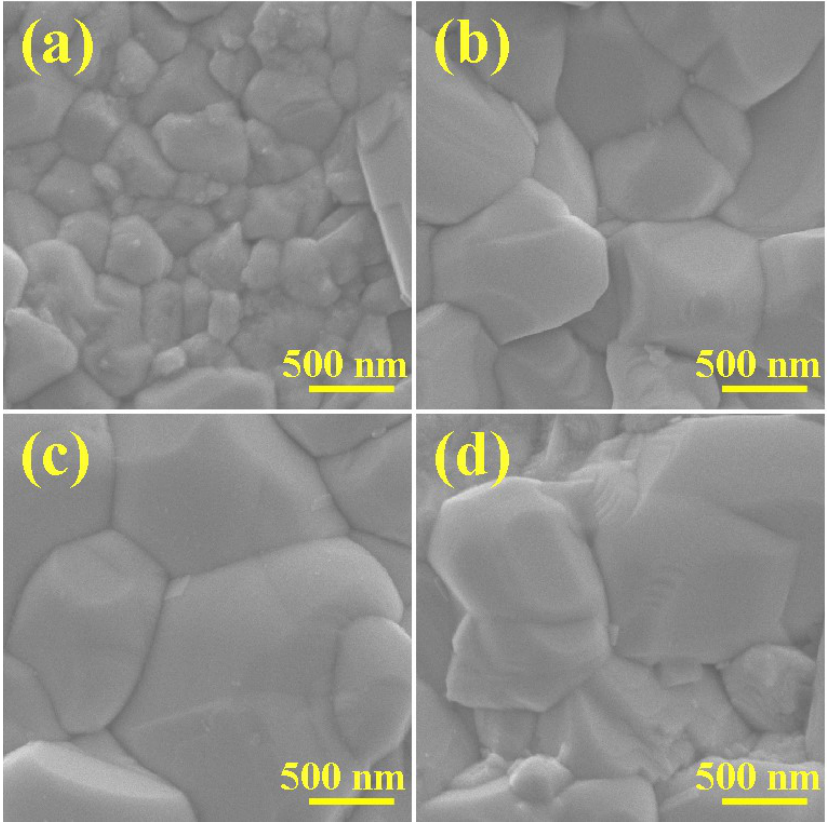
Figure 5. SEM images of Cu 2 ZnSn(S,Se) 4 film selenized at ( a ) 540 °C and Na-doped Cu 2 ZnSn(S,Se) 4 films selenized at ( b ) 520 °C; ( c ) 540 °C; ( d ) 560 °C. To survey the impact of selenization temperatures on the optical band gaps of Na- doped Cu 2 ZnSn(S,Se) 4 , the optical absorption of the samples were obtained by a UV–VIS– NIR spectrophotometer. On the basis of the solid band theory, the relational expression between the energy of the incident ray ( h υ ) and the absorption coefficient ( α ) can be expressed as: